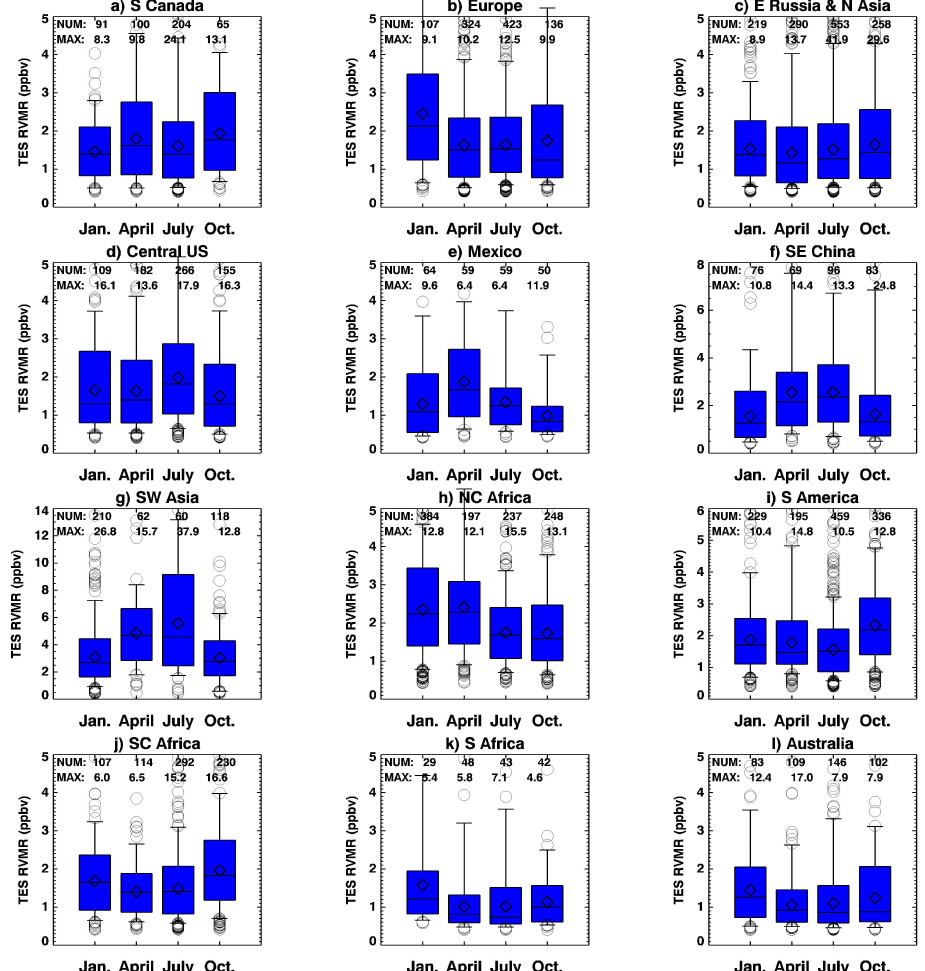
Fig. 15. TES NH 3 averages in Fig. 11 for each region in Fig. 14 for the 4yr period spanning 2006–2009. The boxes are the 25 and 75 percentile, the line in the box is the median, the diamond is the mean, whiskers are the 10 and 90 percentile and the circles are the outlier values outside the